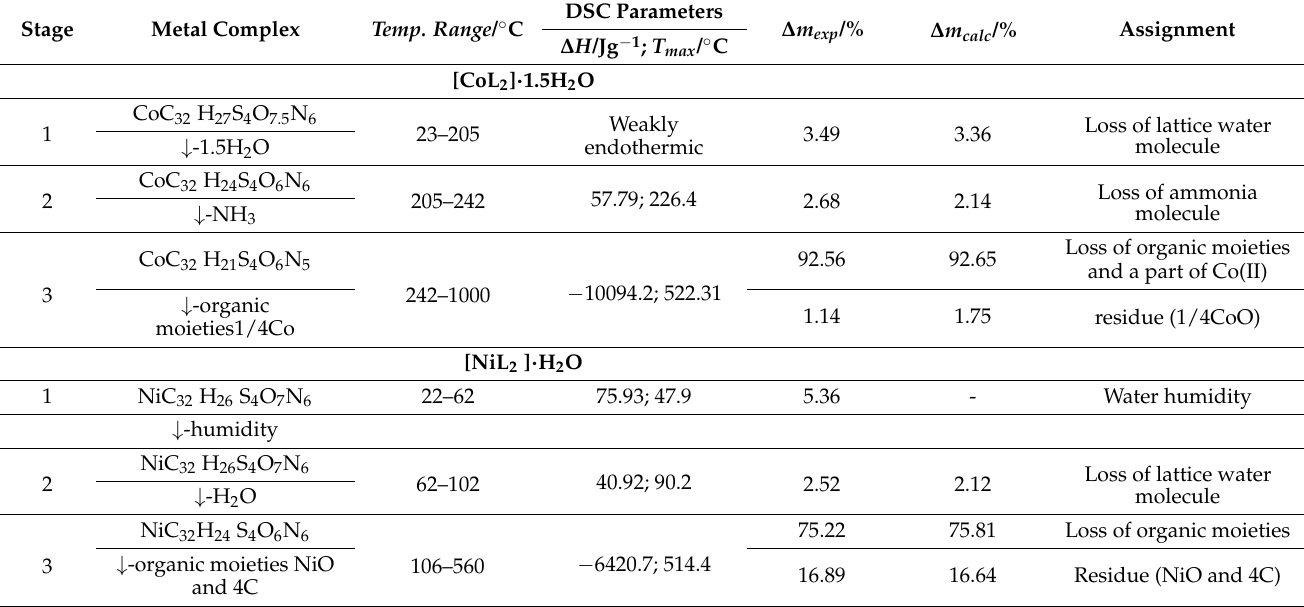
Table 2. Thermal behavior of metal